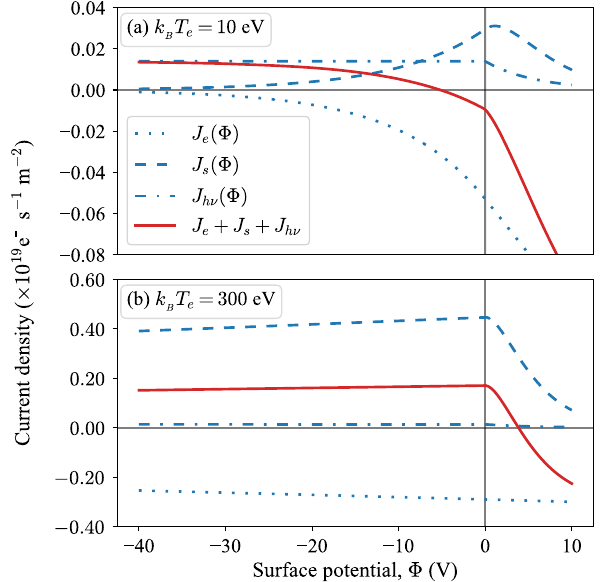
FIG. 3. Charging currents in the LHC for electrons impinging on a Cu dust grain with an energy of (a) 10 eV (b) 300 eV. The photoelectric emission current is independent of the electron cloud and is computed assuming 10 18 s − 1 m − 2 photons. The equilibrium potential corresponds to the potential where the net current is J